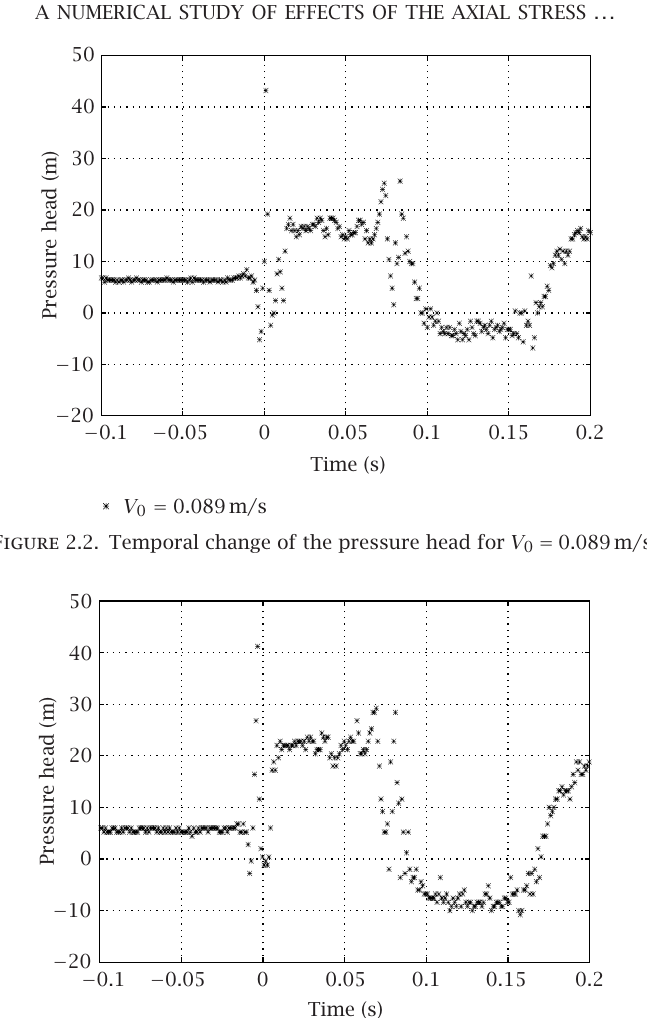
Figure 2.3 . Temporal change of the pressure head for V